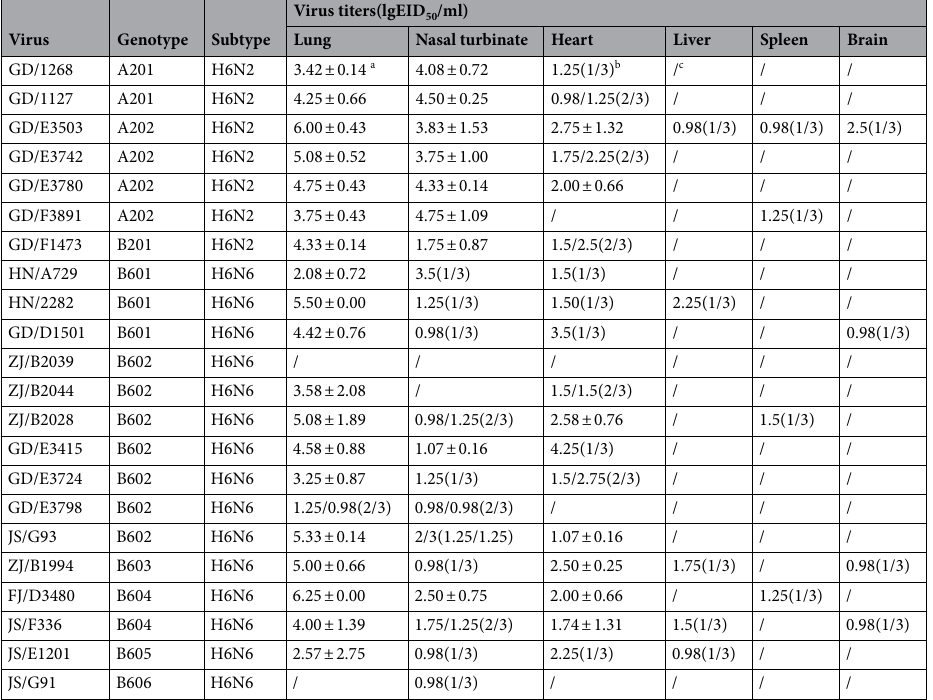
Table 4. Replication of H6 viruses in mice. a Virus was detected in all of three mice, the virus titers were shown as mean ± SEM. b Virus was detected in part of three mice, the virus titers were shown respectively. c Virus was not detected in any of three